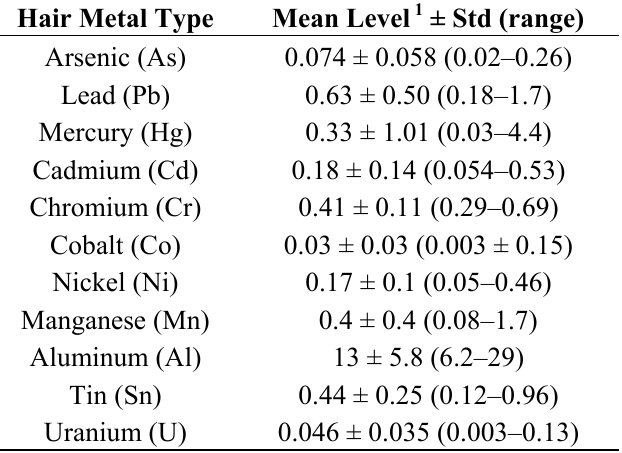
Table 2. A summary of hair toxic metal concentrations among participants diagnosed with an ASD